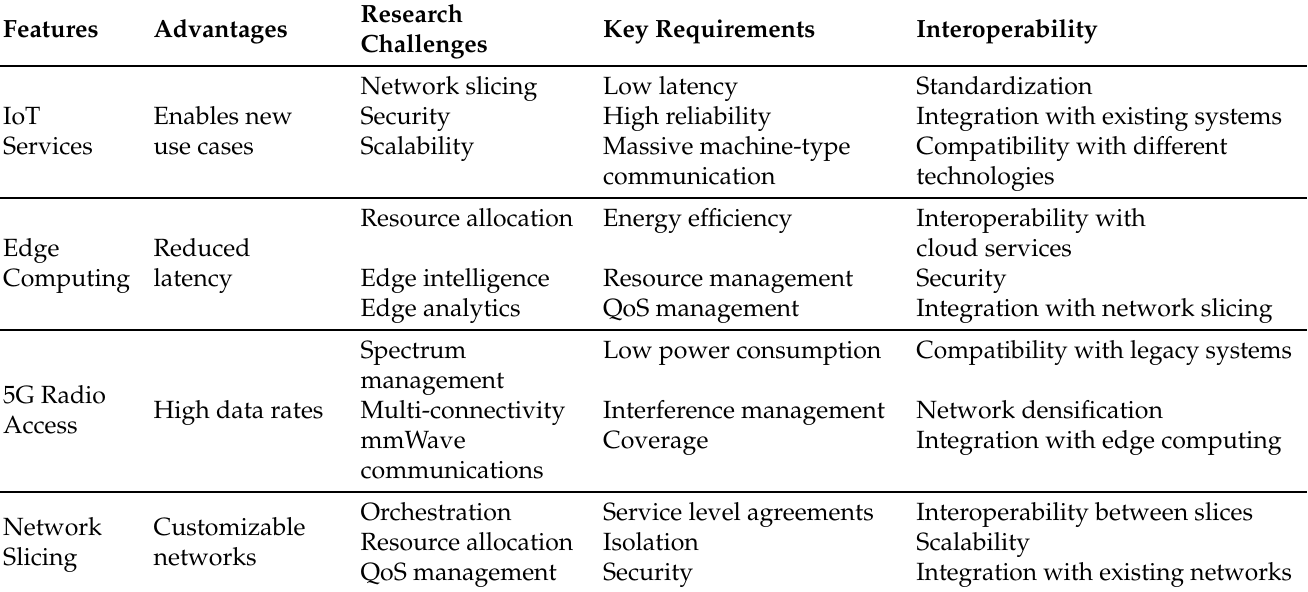
Table 11. Future research challenges in 5G related to IoT